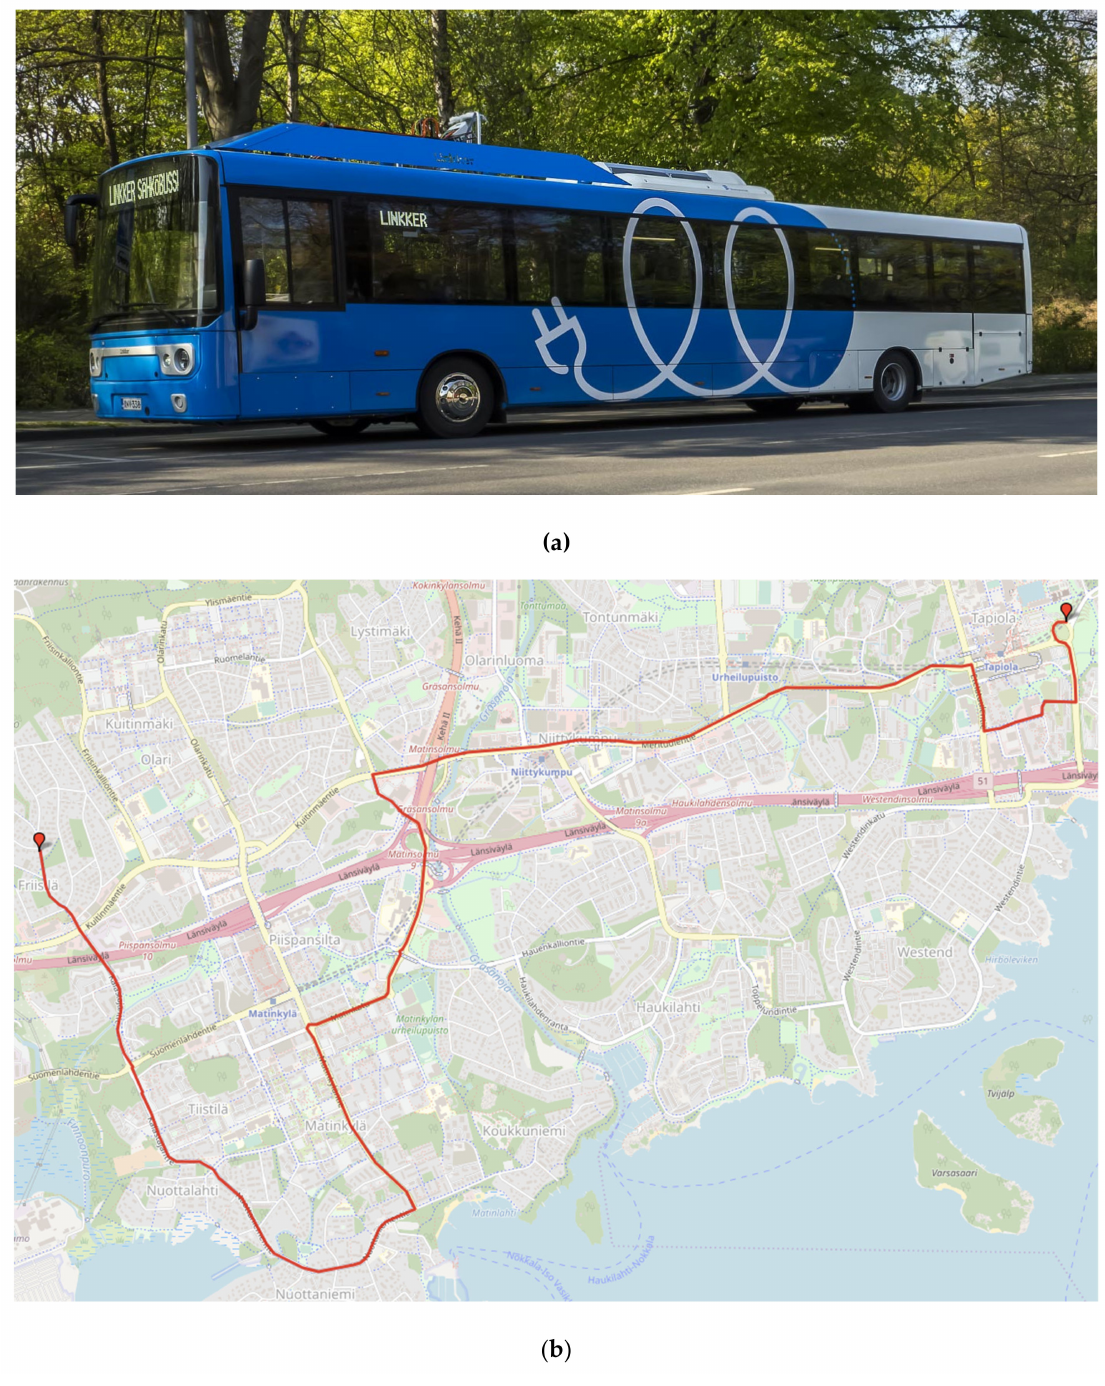
Figure 6. ( a ) The case study ECB operating in Espoo, Finland; ( b ) The bus route 11 in Espoo. Map data is by